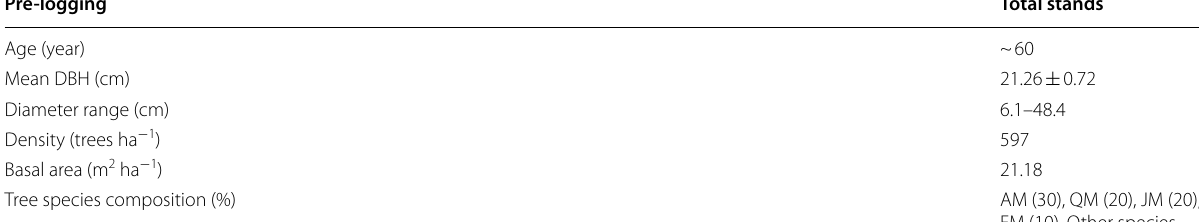
Table 2 Basic information of pre- and post-logging stands in secondary forests